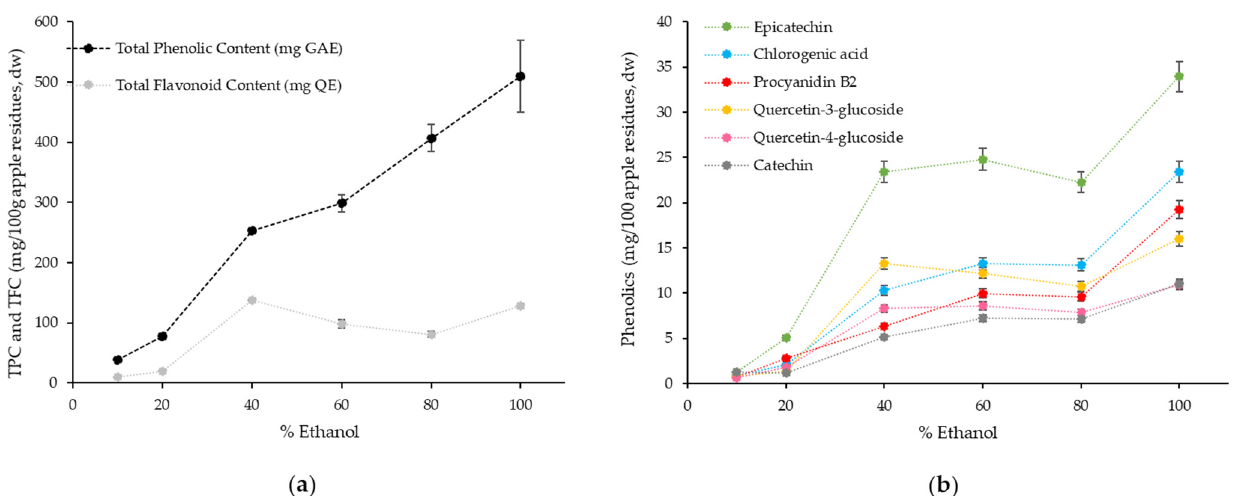
Figure 1. Effect of ethanol (EtOH) concentration on phenolic compounds extracted from BE apple residues with high- pressure technology: ( a ) total phenolics and total flavonoids recovery (mg/100 g raw material, dw); ( b ) individual phenolics recovery (mg/100 g raw material, dw).